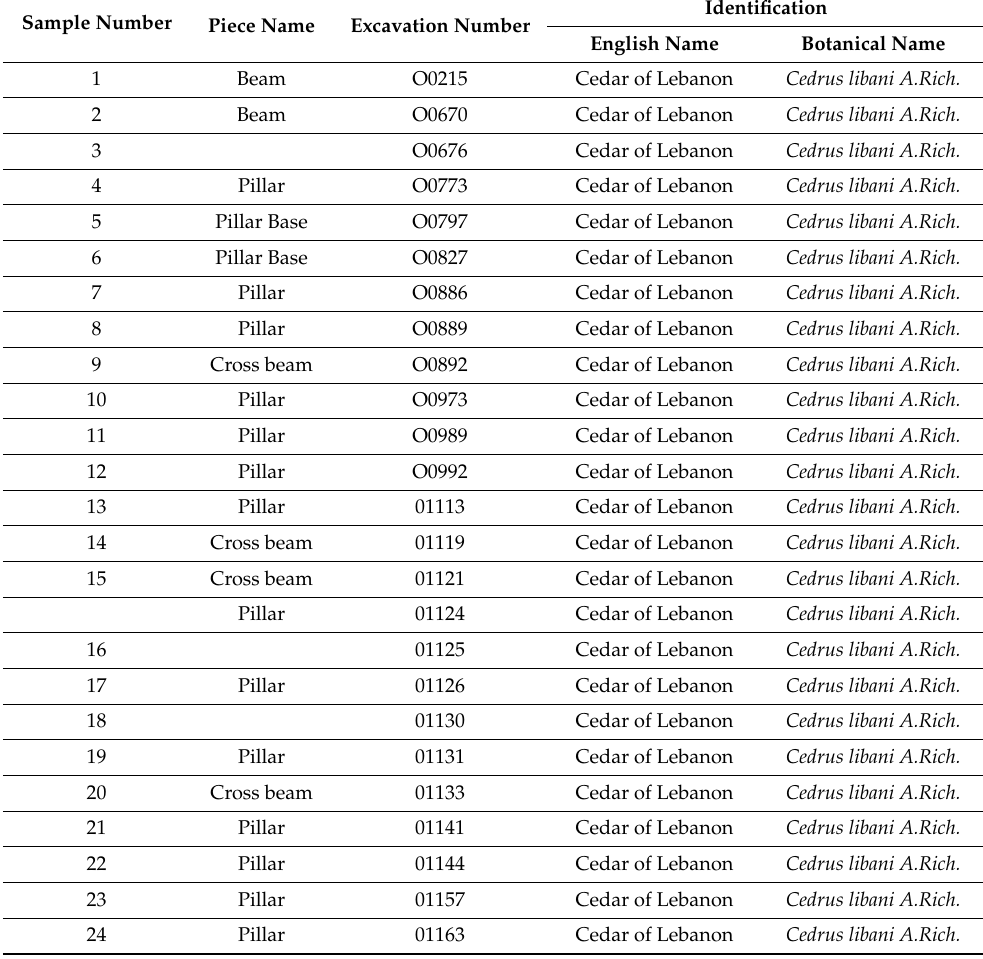
Table 2. Samplenumber, piecename, excavationnumber,